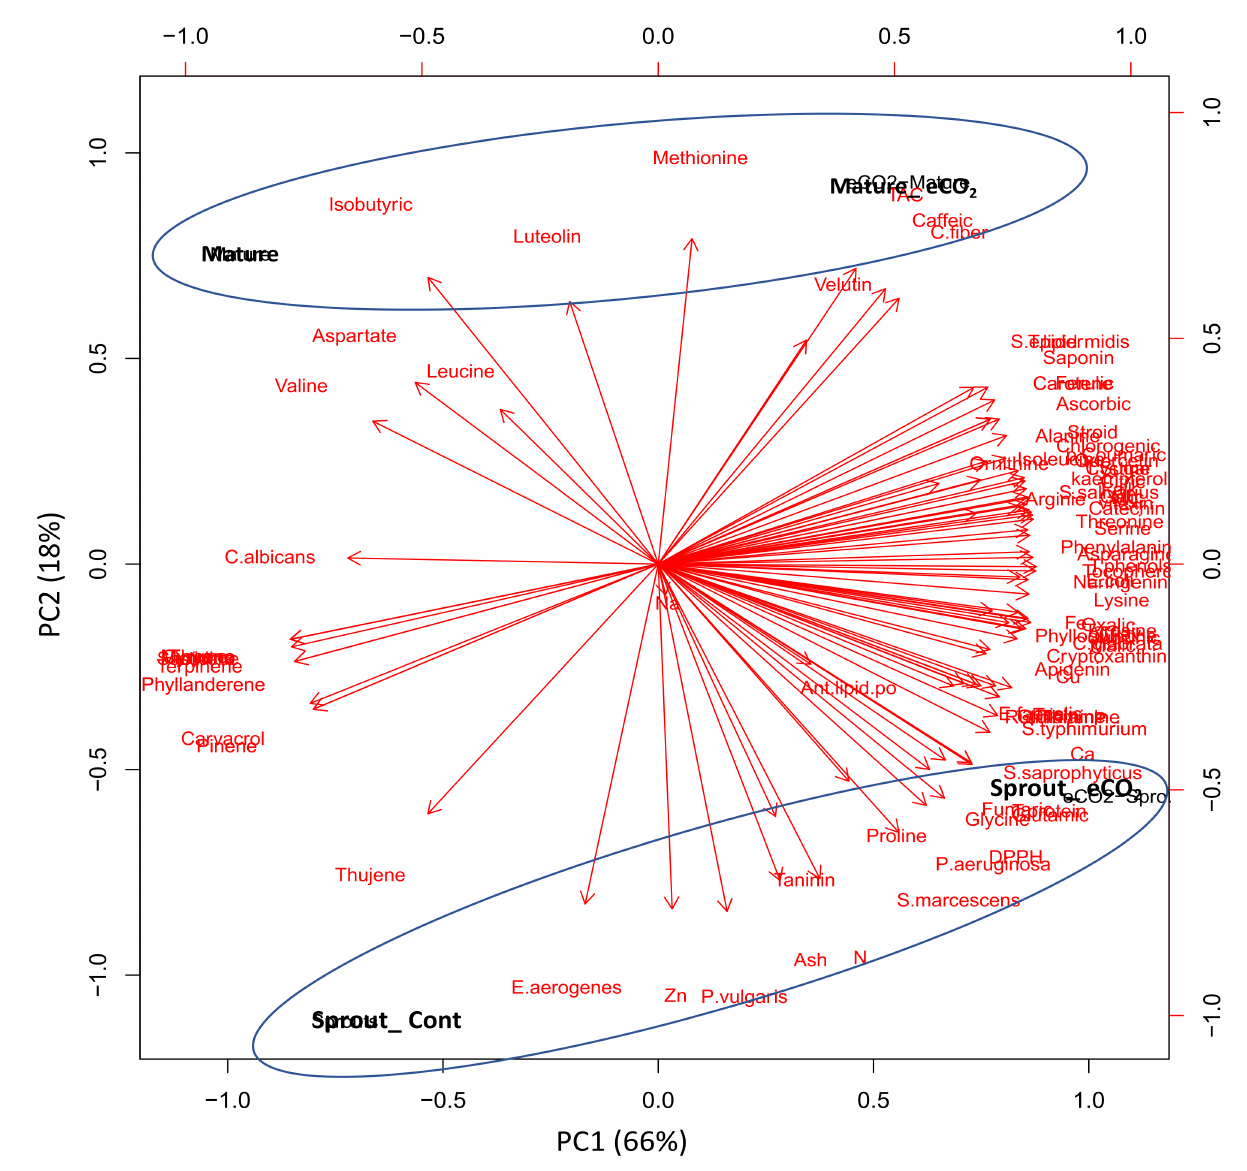
Figure 4. Principal component analysis (PCA) of chemical compositions and biological activities of caraway plants at two developmental stages (sprout and mature tissues) under control or eCO 2 growth